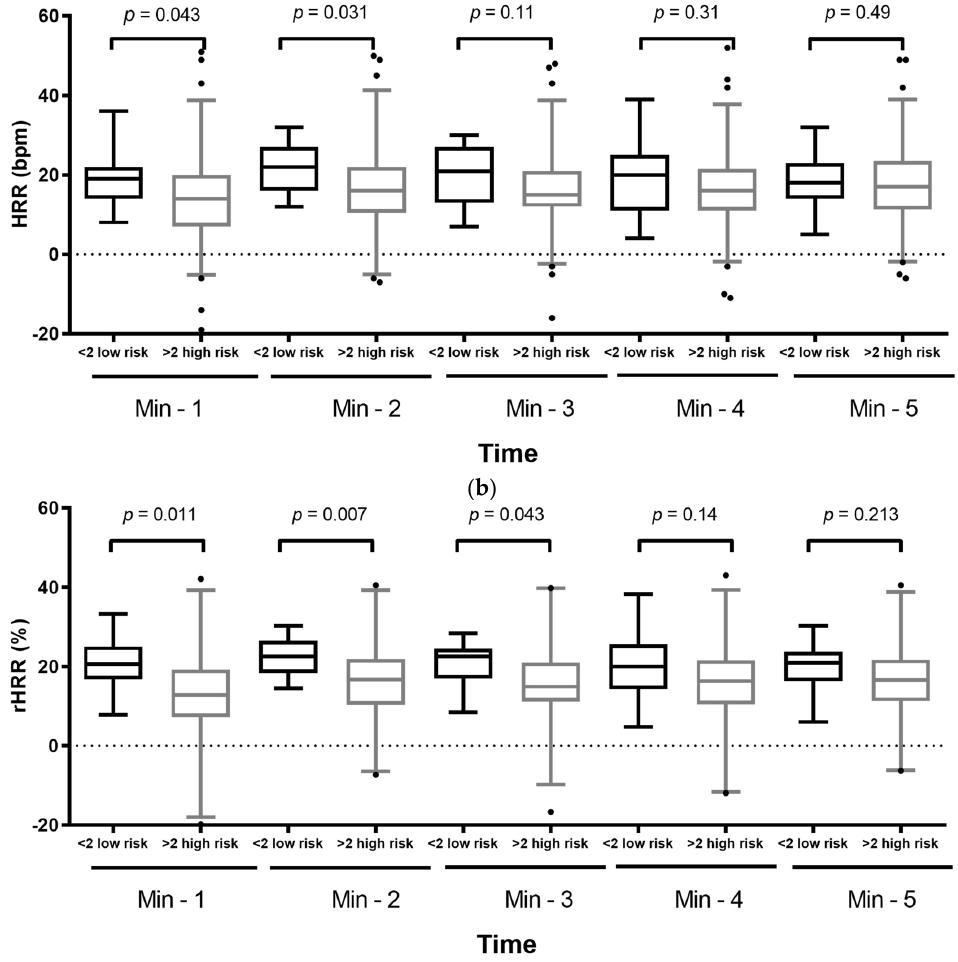
Figure 2. ( a ) A high atherogenic coefficient affects heart rate (HR), ( b ) heart rate recovery (HRR), and ( c ) relative heart rate recovery (rHRR). Boxplot graphs comparing low-risk < 2 atherogenic coefficient and high-risk > 2 atherogenic coefficient at each minute after the 6-min walking test. A Wilcoxon rank–sum test was used to compare the two groups; p -values are shown above each